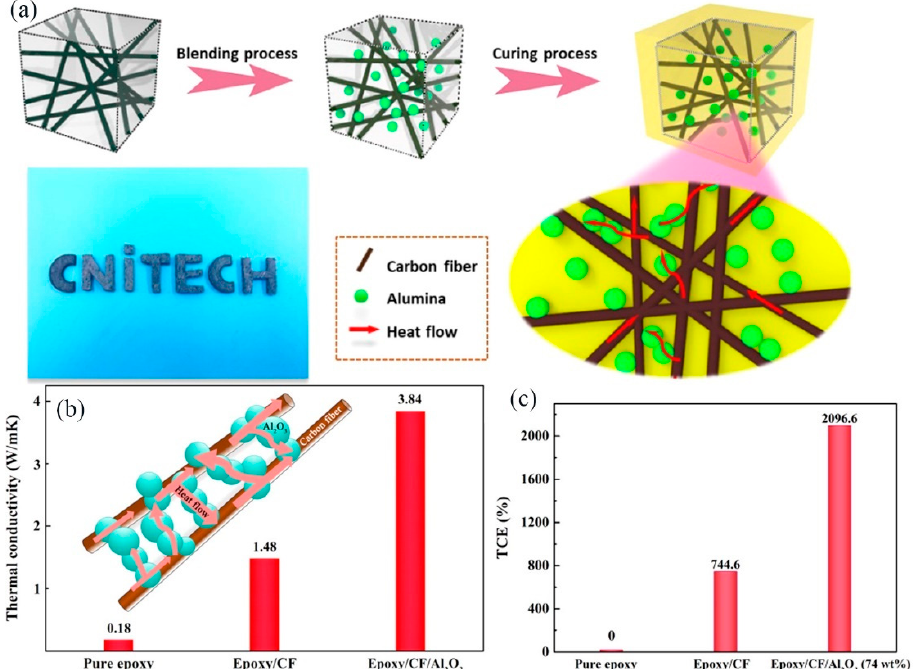
Figure 10. ( a ) Schematic diagram of the SCFNA method for the preparation of the PDMS/SCF/glass bubbles (GB) composites. ( b ) λ and ( c ) elongation-at-break of the PDMS/SCF/GB composites at different thicknesses of sample. ( d ) The thermally conductive network conversion from “sand-like” to “stone-like” [132].